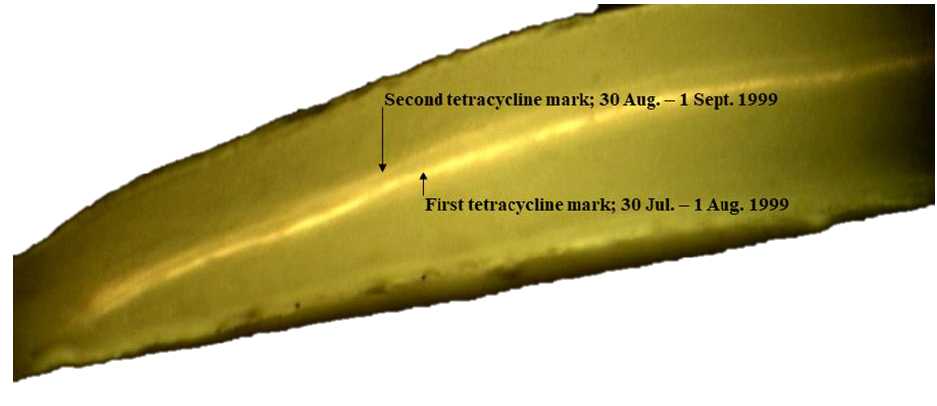
Fig. 9. Tetracycline marking in untreated harbour porpoise ( Phocoena phocoena ) dentine showing fluorescence under reflected UV